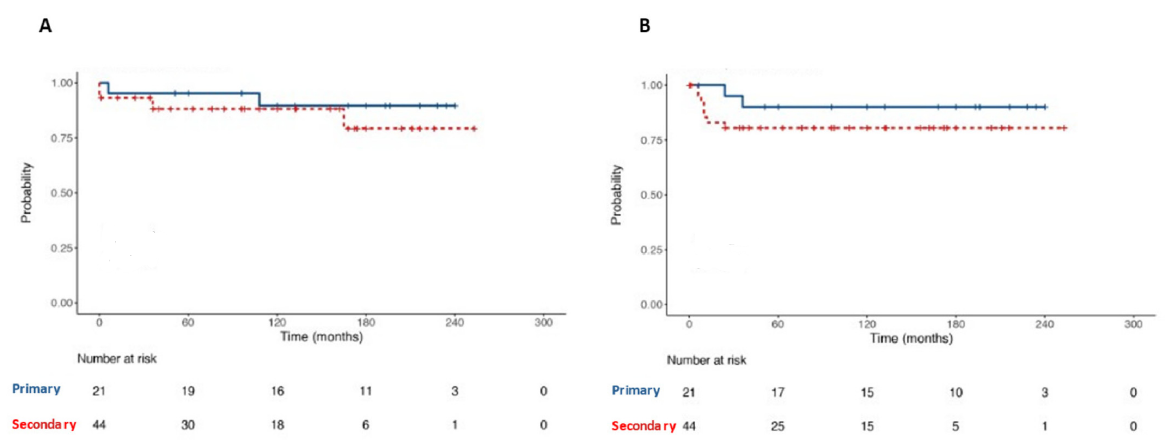
Figure 7. Kaplan–Meier with log-rank test for comparison of Overall Survival ( A ) and Recurrence- Free Survival ( B ) between primary and secondary RPLND subgroups patients.